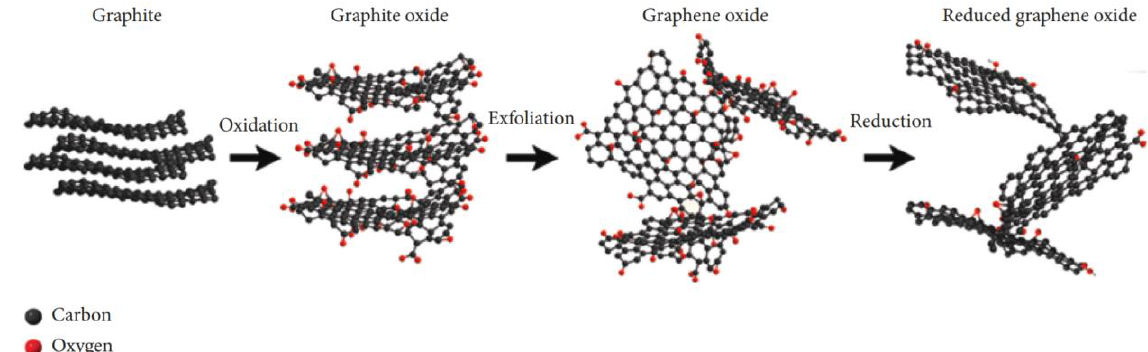
Figure 3. Structure of graphene, graphene oxide and reduced graphene oxide [62].